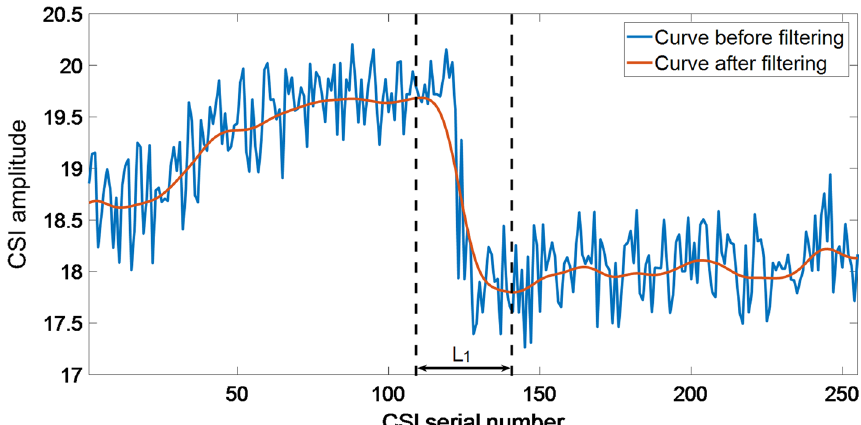
Fig. 3 Comparison of the effects before and after using Gaussian